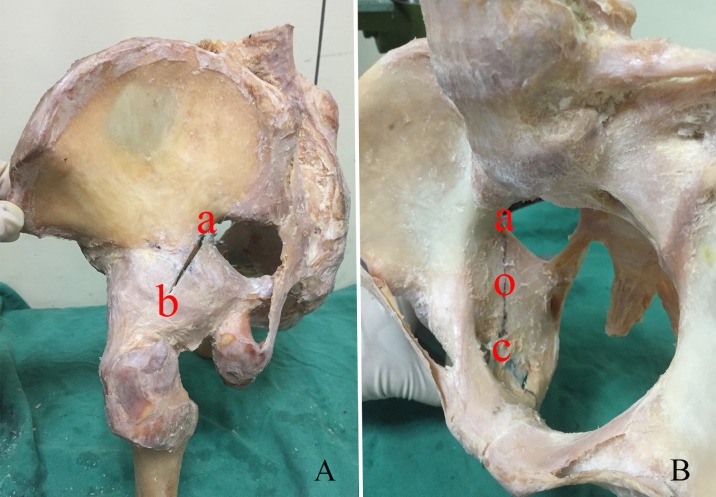
Posterior column fracture of the acetabulum.The osteotomy line originated from the vertex of the greater sciatic notch (a) to the center of the quadrilateral surface (o), the outside pelvis of the converging line went through the 2 o’clock of the left posterior acetabulum and ran along the posterior brim of incisura acetabula (c) to separate the ramus ossis ischia.